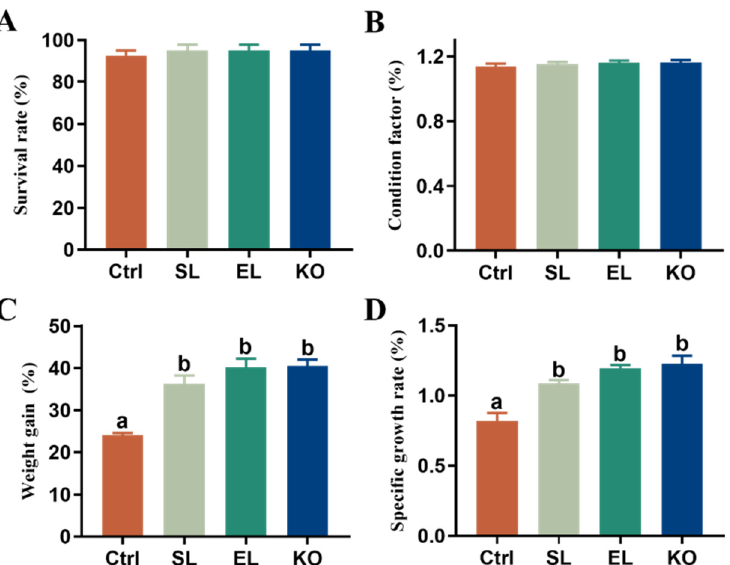
Figure 1. Growth phenotypes of female L. vannamei fed different experimental diets. ( A ) Survival rate. ( B ) Condition factor. ( C ) Weight gain. ( D ) Specific growth rate. The values are the mean ± standard errors ( n = 4). Values with different superscript letters indicate significant differences ( p < 0.05) among all the